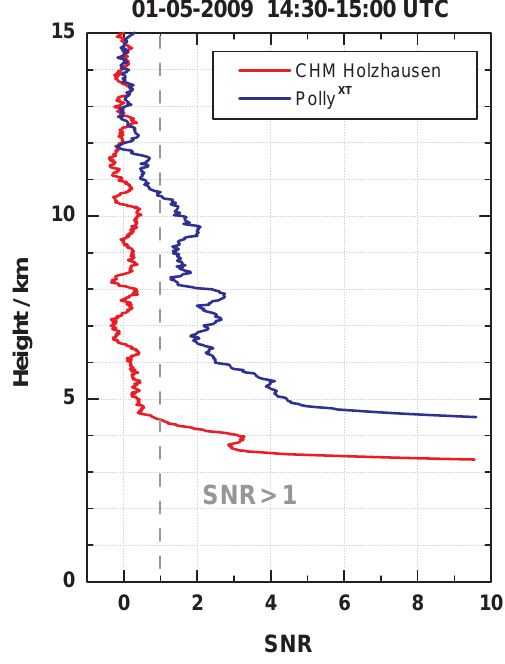
Fig. 5. SNR of 30min mean CHX ceilometer and lidar signals on 25 May 2009 during